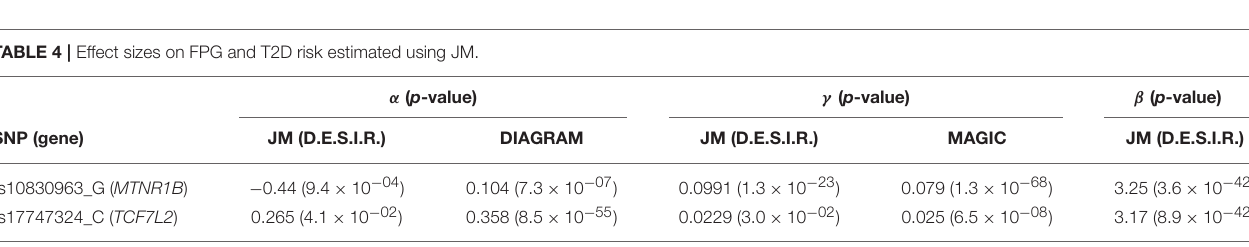
FIGURE 7 | Manhattan plot for estimated effects of γ and α using “JM” (Rizopoulos, 2010, 2017). Results are presented for the cleaned set of 101,305 SNPs.